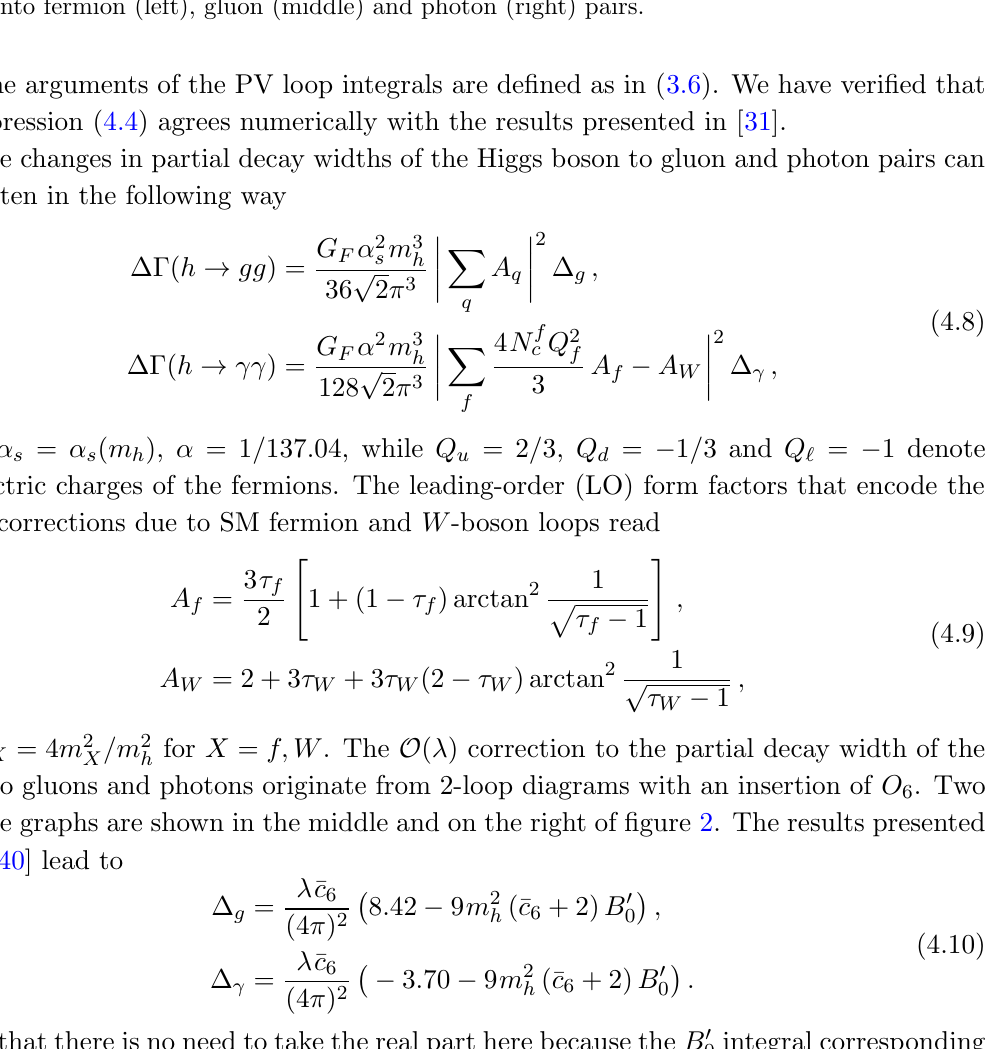
6 that lead to Higgs-boson